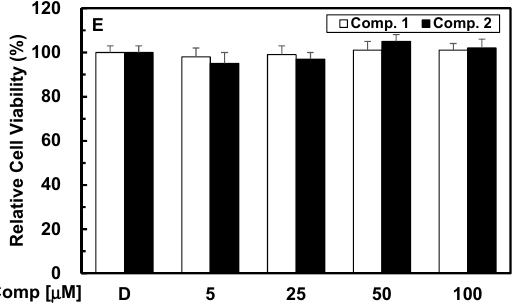
Figure 3. Effects of 1 or 2 on cellular viability was measured by MTT assay. D = 0.2% DMSO is the vehicle control.